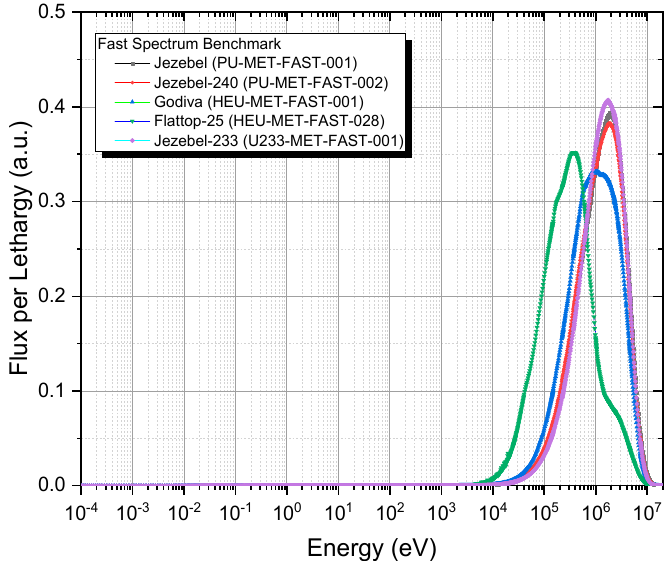
Energies 2022 , 15 , x FOR PEER REVIEW Figure 2. Spectra of example fast benchmark problems . Figure 2. Spectra of example fast benchmark problems.